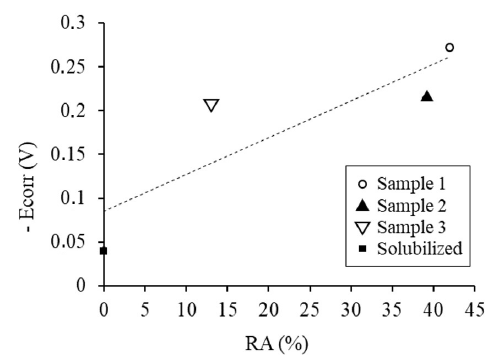
Figure 7. Effect of the area reduction on the corrosion potential of superaustenitic stainless steel in 3.5% NaCl solution.